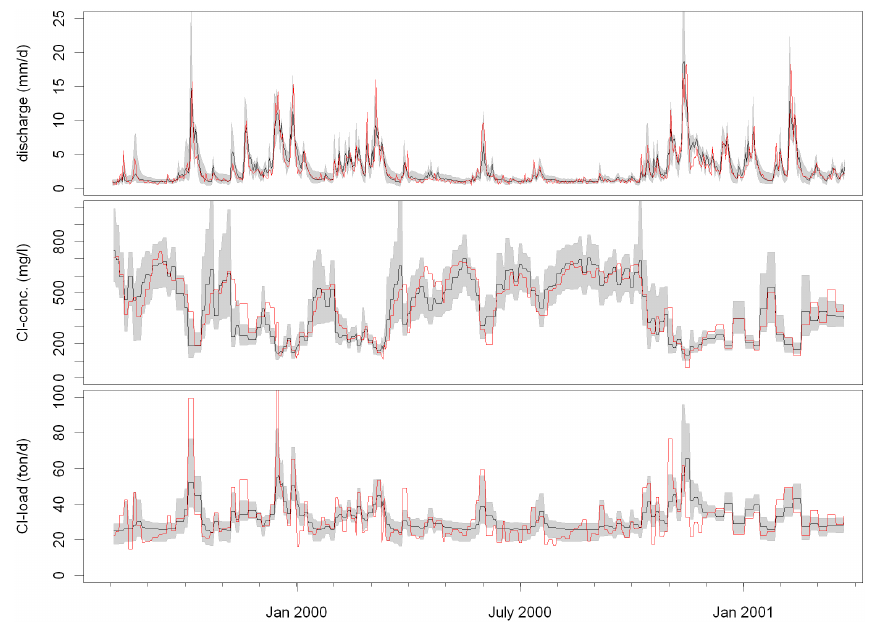
Fig. 3. Observed (red) and modelled (median, black) polder water discharge, chloride concentration of discharge water and total chloride loads. Grey area indicates the uncertainty of the model output estimate characterized by the minimum and maximum of the entire ensemble of 59630 behavioural simulations (GLUE analysis